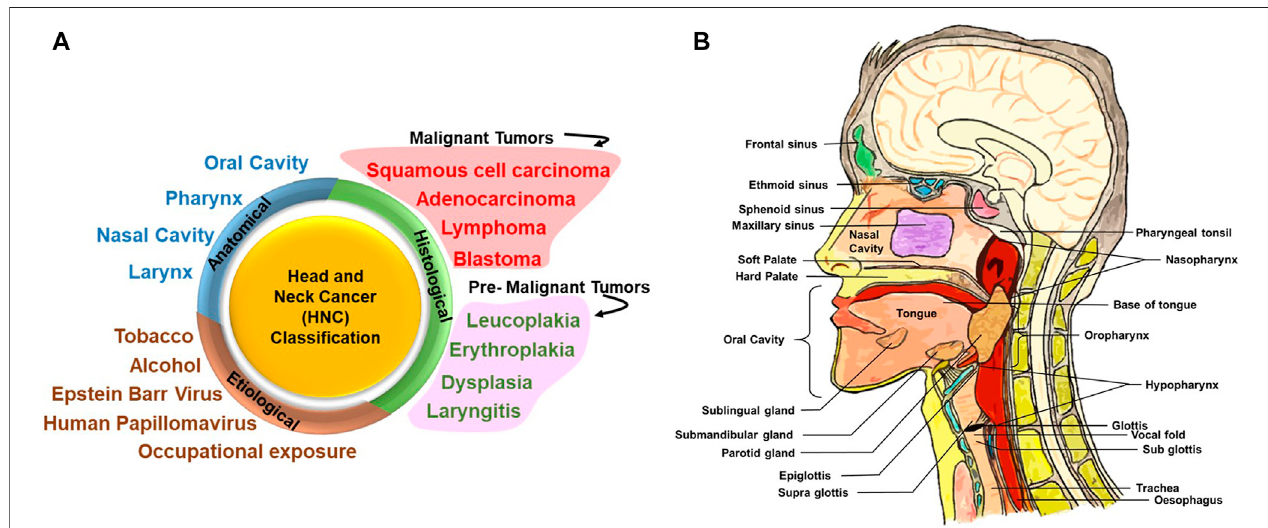
FIGURE1| Headandneckcancer(HNC)classi fi cationanddifferentanatomicalsitesinvolved. (A) HNCcanbebroadlyclassi fi edonthebasisofitsanatomicalsite, histological origin, and etiological factors. Upon histological evaluation, tumors in the head and neck region can be broadly classi fi ed into malignant and premalignant lesions. Premalignant lesions that have been indicated here are not cancer but are precursors of malignant lesions. (B) Detailed anatomical architecture of the head and neck region illustrating the location of the oral cavity, nasal cavity, tongue, salivary glands (sublingual gland, submaxillary gland, and parotid gland), larynx and pharynx (including oropharynx, nasopharynx, and hypopharynx), and site of primary